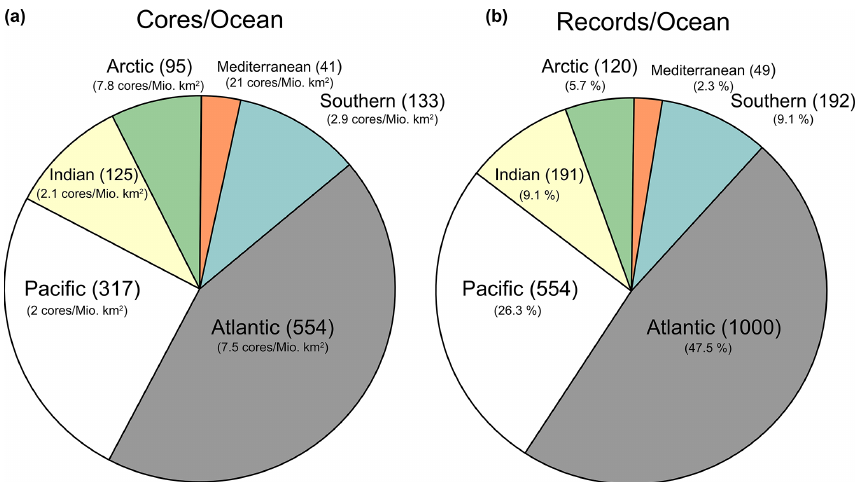
Figure 4. Number of cores (a) and records (b) for major ocean basins. A record is a downcore series of paired oxygen and carbon isotope measurements on a foraminiferal species or species group stored in a single netCDF file. Several records can exist for a single core. The counts include records/cores for which either δ 18 O or δ 13 C is missing. Numbers in small font below ocean basin name indicate density of cores in cores/10 6 km 2 (a) and percentage from the total number of records in the atlas (b) in each basin. Ocean basins follow the definitions in the World Ocean Atlas 2001 (Stephens et al., 2002). Pacific includes the Sea of Japan and the Indian Ocean includes the Bay of Bengal and the Red